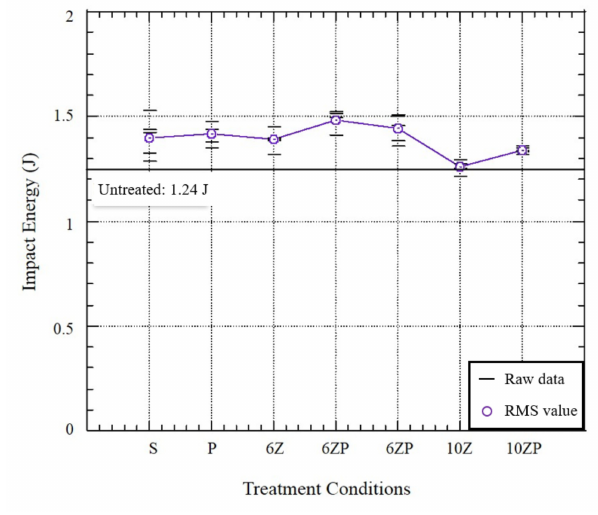
Figure 7. Impact energy of 6-layer aramid fabric under various conditions.